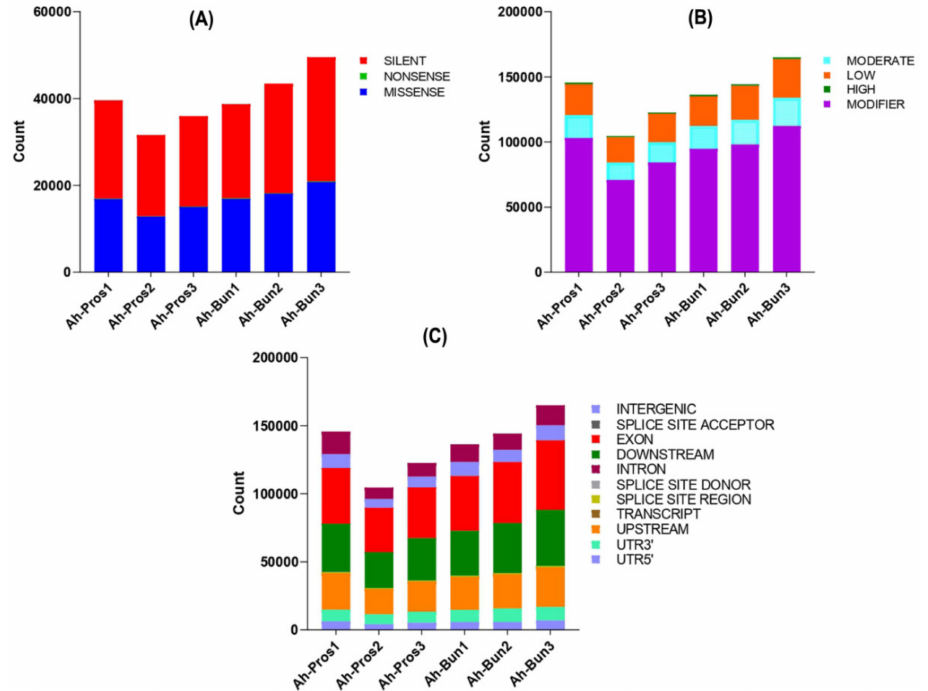
Figure 7. The statistics of SNPs and variant sites identified between prostrate and bunch peanut using GATK tools. ( A ) The identification of variant site function statistics. ( B ) Variant site area statistics, and ( C ) variant site impact statistics. The abscissa in the figure represents the sample name, and the ordinate represents the amount of